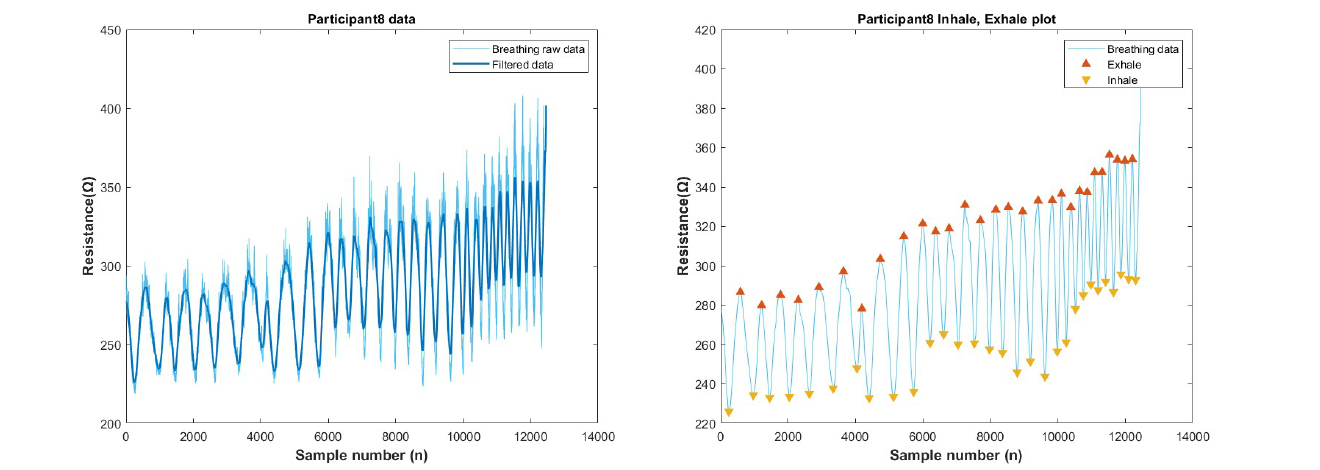
Figure A23. Breathing Test data of Participant number-8.